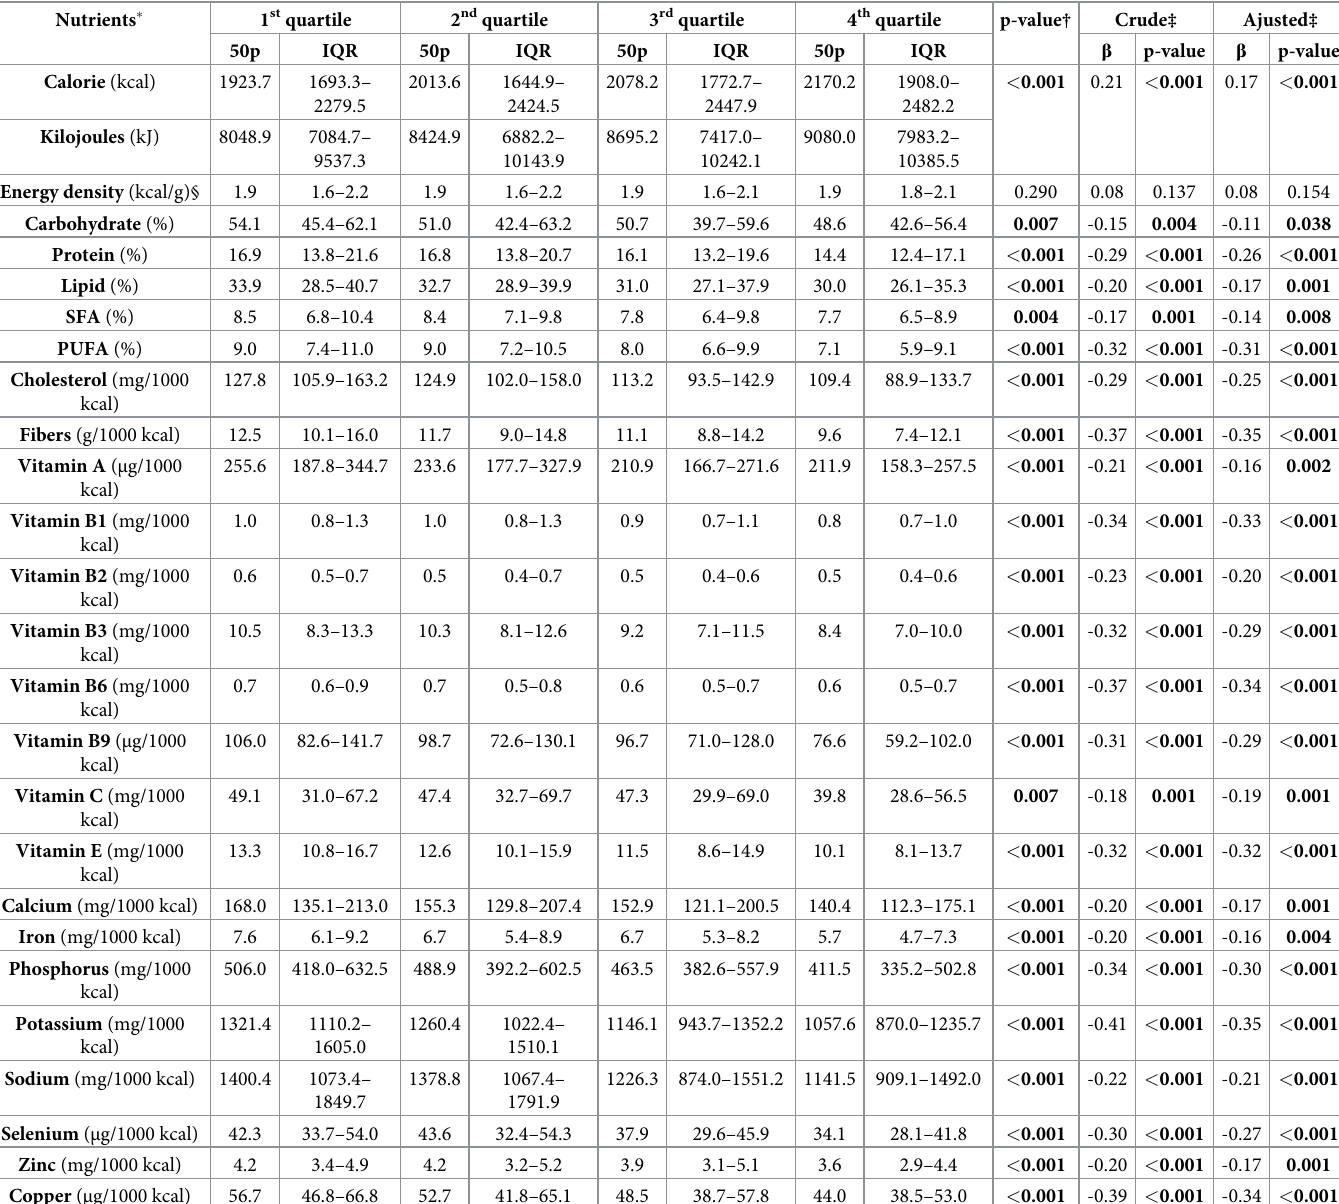
Table 7. Diet’s nutritional profile according to the caloric contribution of the consumption of ultra-processed foods by Brazilian